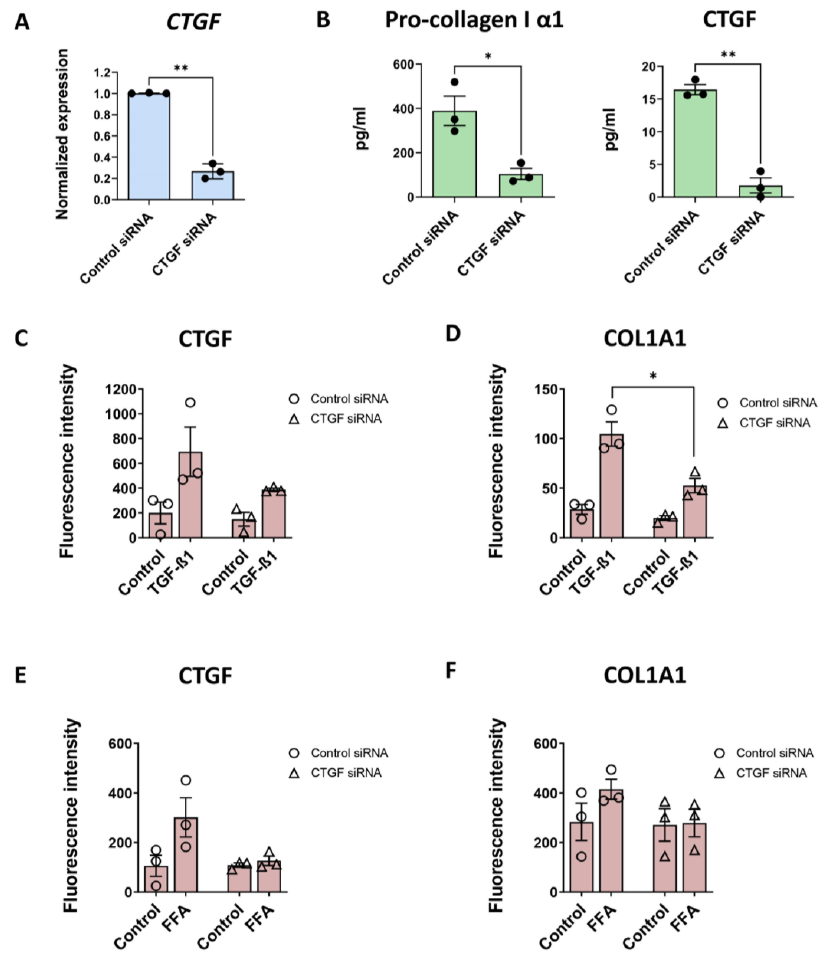
Figure 6. CTGF silencing reduces the COL1A1 production induced by TGF- β1 . CTGF silencing was evaluated for TGF- β1 - and FFA-induced CTGF and COL1A1 deposition. Spheroids were maintained and treated as shown in Figure 1. Blue bars present the mRNA level data, red bars present results of IHC analysis and green bars, data acquired using ELISA. ( A ) Silencing of CTGF was confirmed at the transcriptional level 10 days after seeding and transfection (n = 3). ( B ) CTGF silencing also reduced baseline pro-collagen I α 1 and CTGF released in the medium in the last 3 days of culture (n = 3). ( C , D ) CTGF siRNA-transfection caused a decrease in TGF- β 1-induced CTGF and COL1A1 production (n = 3). TGF- β 1-induced COL1A1 production was significantly lower in the spheroids with silenced CTGF. ( E , F ) CTGF siRNA-transfection also caused a decrease in FFA-induced CTGF and COL1A1 production, although the difference was not significant. Every dot in the graphs represents data from 1 experiment and those in the red bars present an average of at least 10 analyzed sections of spheroids per experiment. Data are shown as mean ± SEM. Statistical analysis—Student’s t -test; * p < 0.05; ** p <